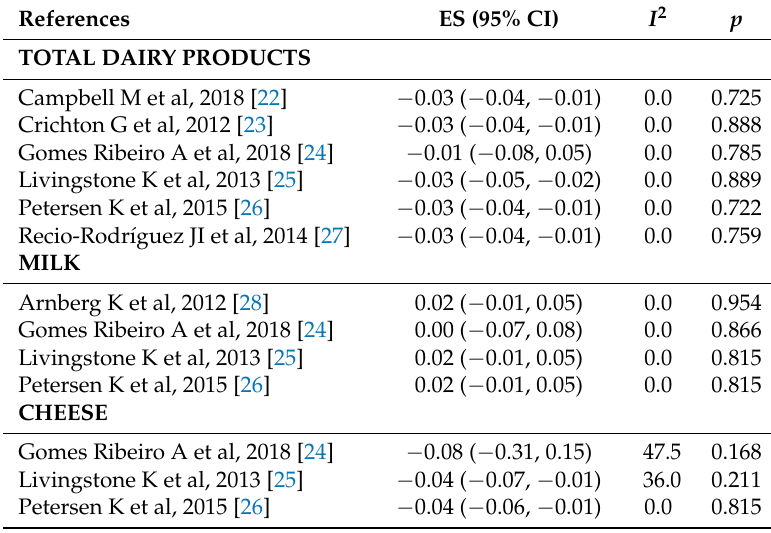
Table 4. Sensitivity analysis by removing one by one the included studies.